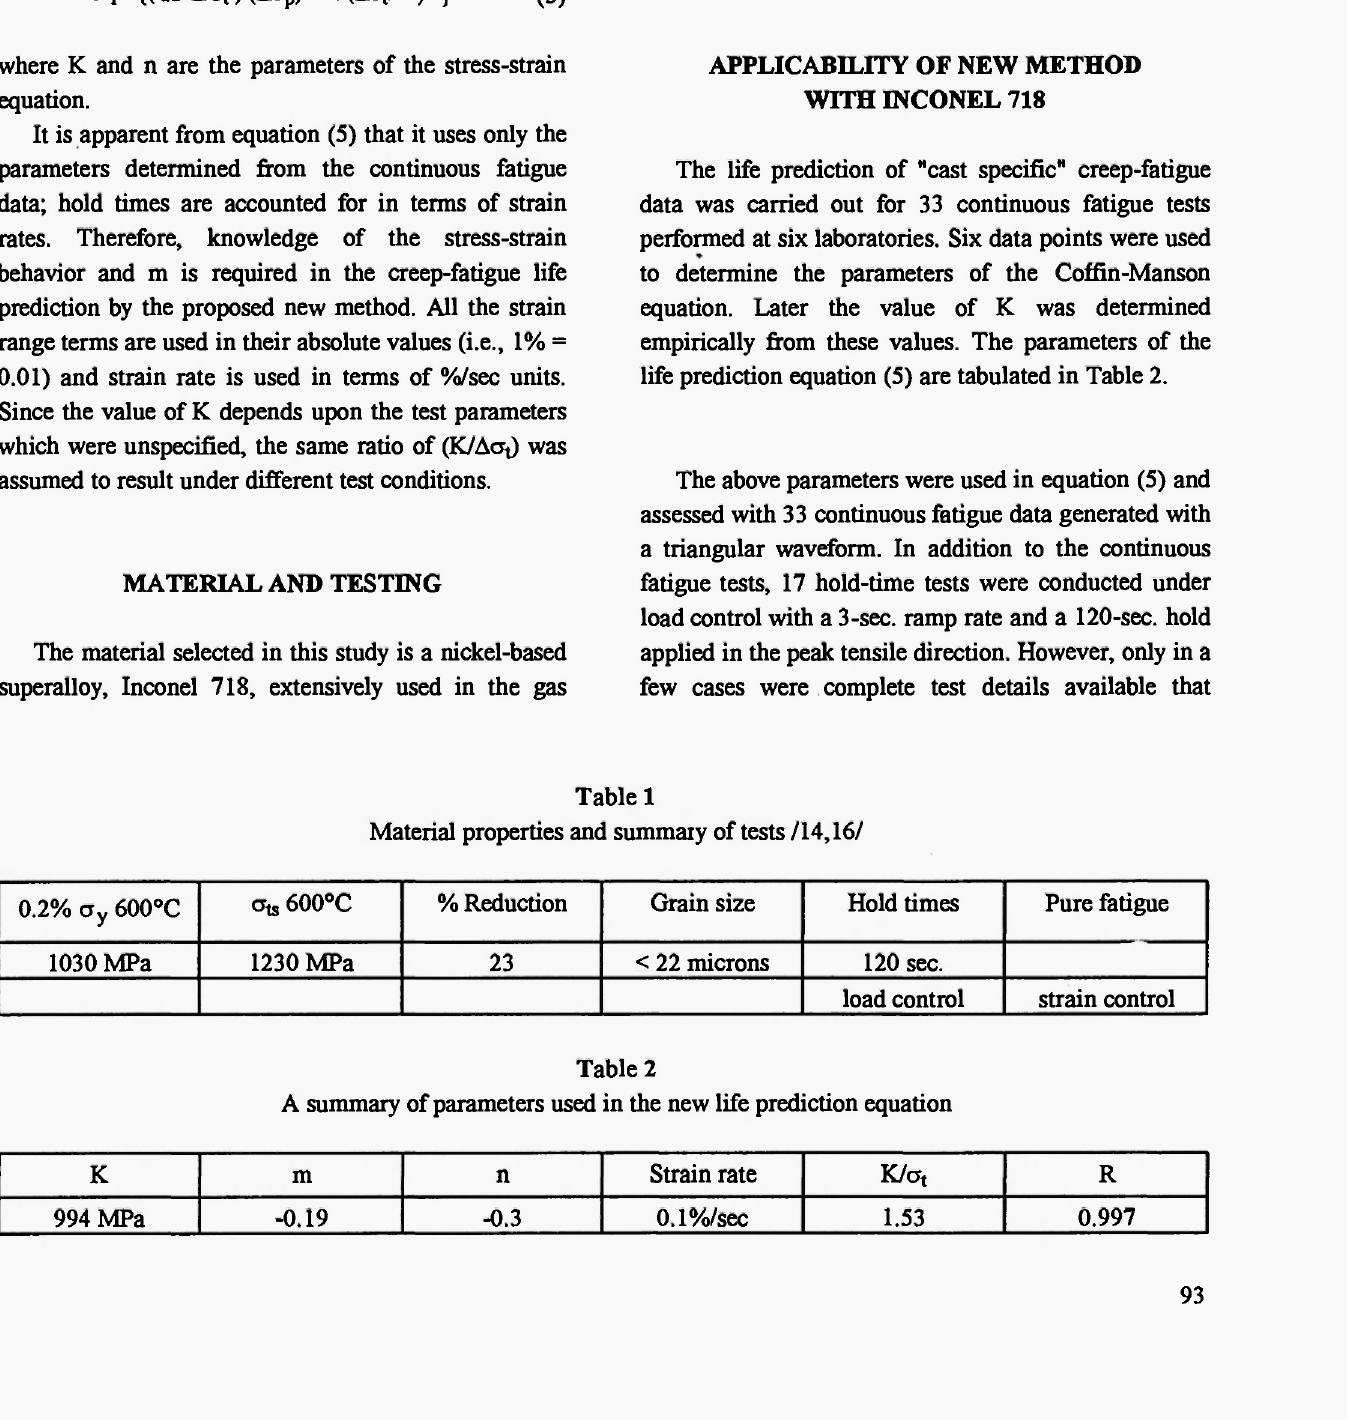
Material properties and summary of tests 714,16/